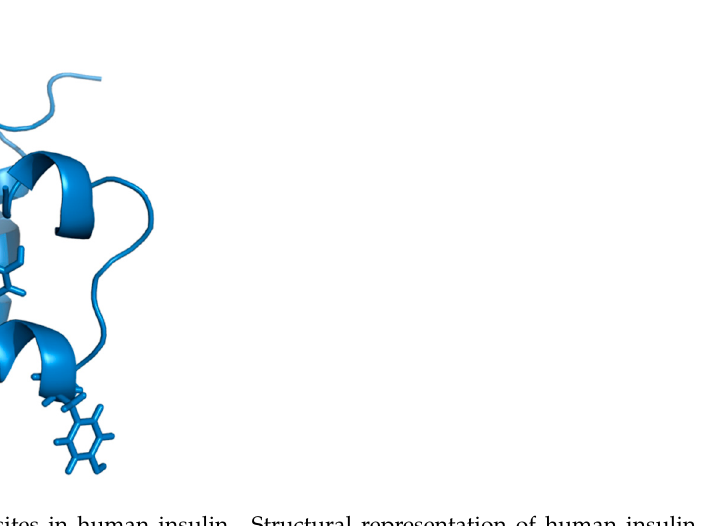
Figure 4. Glycation sites in human insulin. Structural representation of human insulin in its monomeric form (PDB 3AIY). In the tridimensional structure, D -ribose glycation site is represented in orange (Lys29), MG glycation site in gray (Arg22), and tyrosine residues are shown in blue. (LysB29). Emission spectra of native insulin in the absence of glycating agent and HT is also shown for comparison. In the absence of HT, the fluorescence emission of glycated insulin